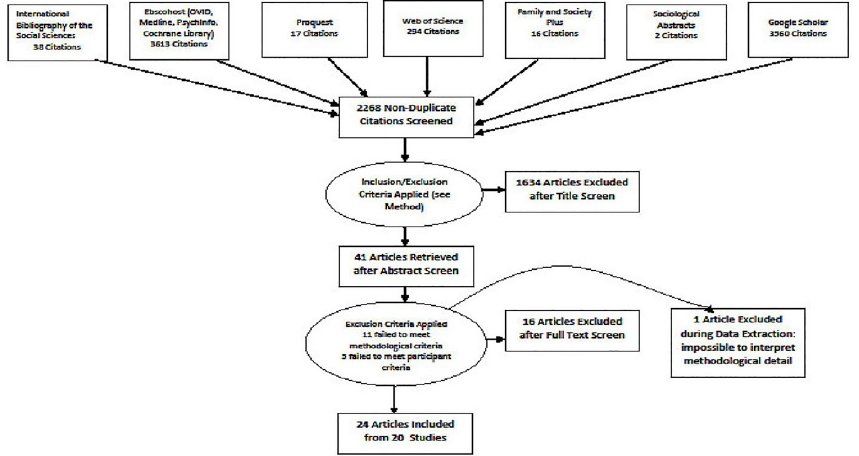
Fig 1. Flow chart: Articles yielded by the search, process of exclusion, & articles (+ studies) reviewed.